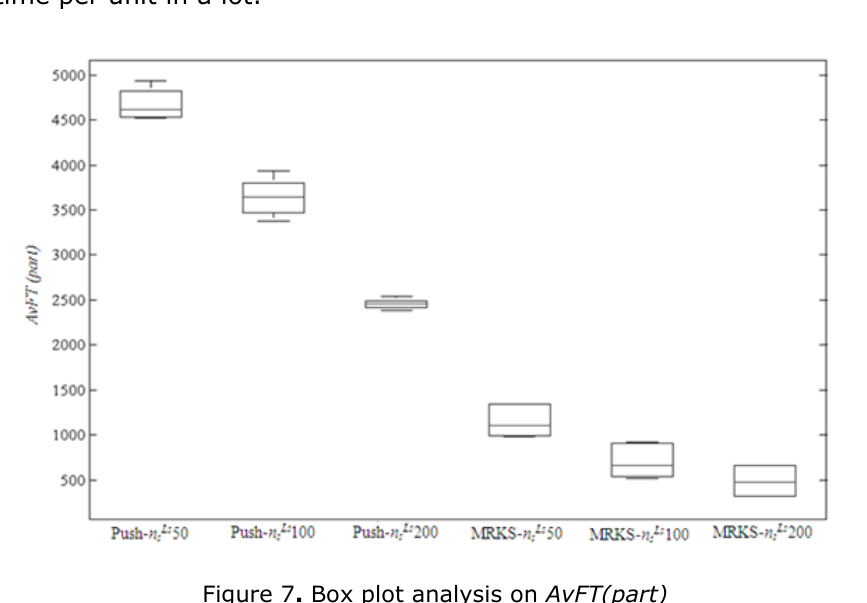
Figure 7 . Box plot analysis on AvFT(part)